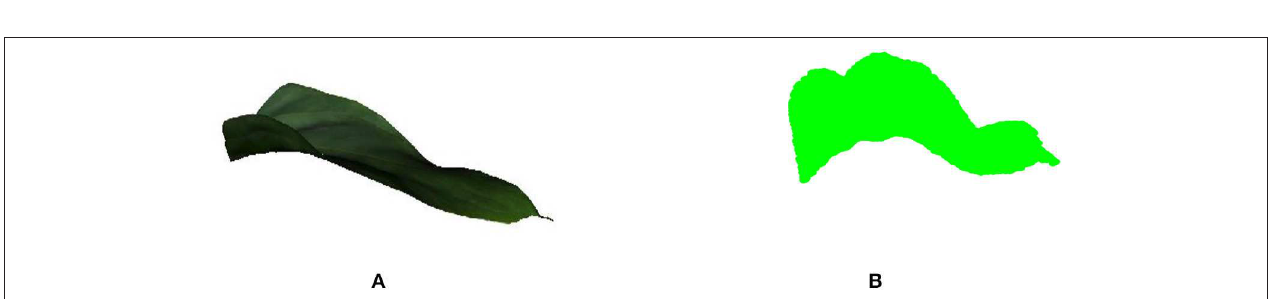
FIGURE 2 | (A) The red represents the triangle vertices and the black dots represent the boundary points. (B) The Anthurium surface triangulation generated using